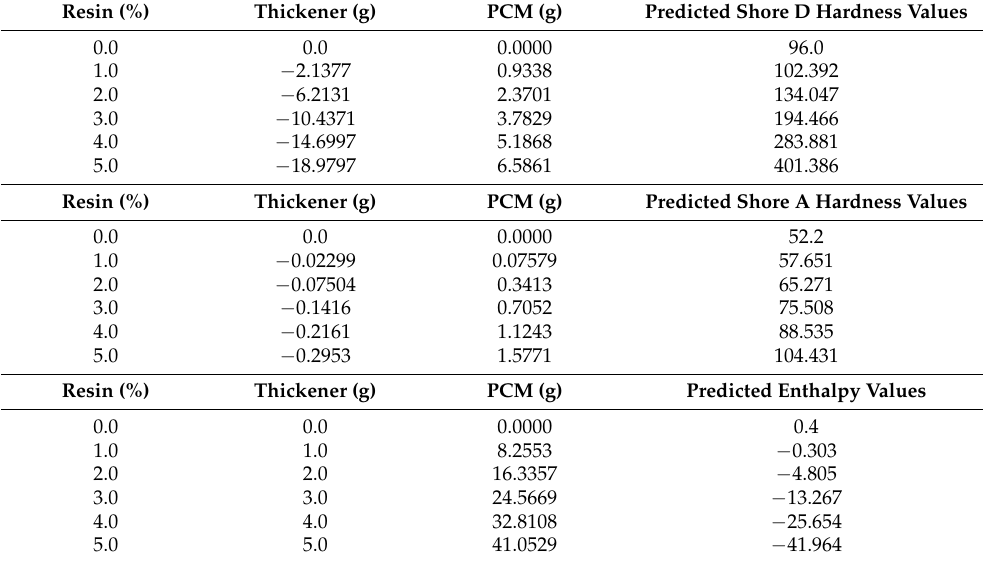
Table 4. Ascending path for Shore D/Shore A hardness and enthalpy, showing the effect of increasing the resin content in six steps of 1%